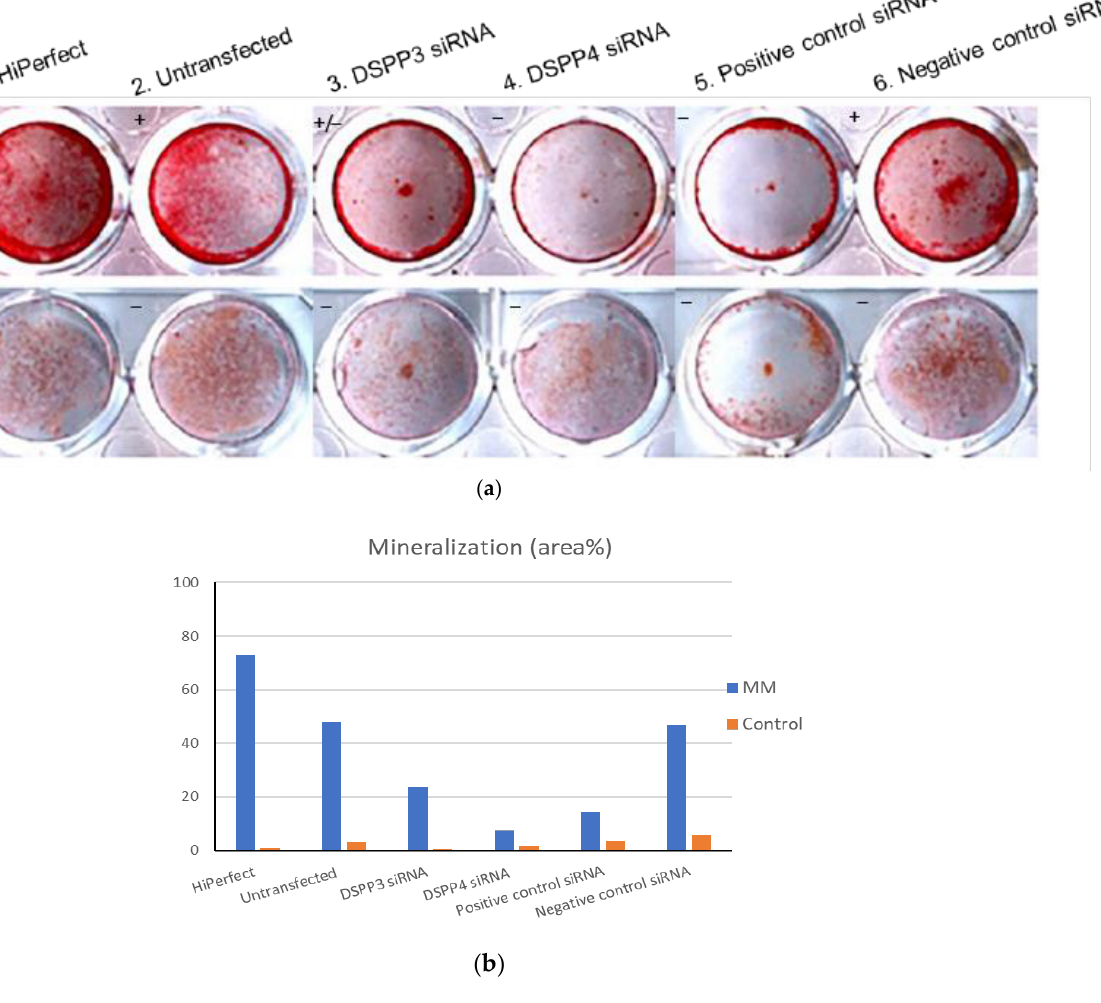
Figure 5. ( a ) Alizarin red stain of MDPC23 cell and mineralization: “+” represents strong minerali- tion; “ − ” represents no mineralization; “+/ − ” represents lower mineralization. ( b ) Area percentages zation; “−” represents no mineralization; “+/−” represents lower mineralization. ( b ) Area percent- of ages of mineralization.